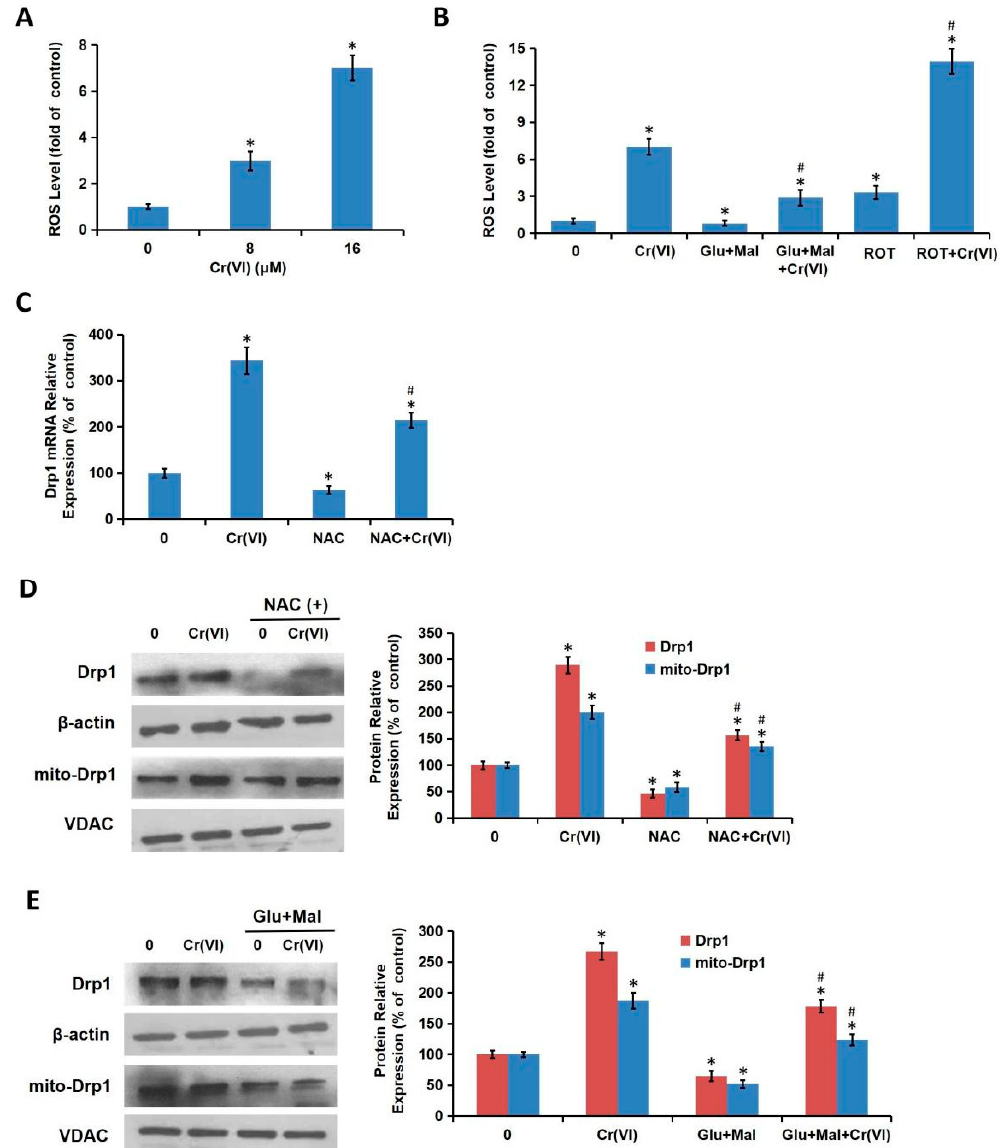
Figure 7. Cr(VI)-induced Drp1 modulation was dependent on MRCC I inhibition-mediated ROS production. ( A ) L02 hepatocytes were treated with di ff erent concentrations of Cr(VI) (0, 8, 16 µ M)